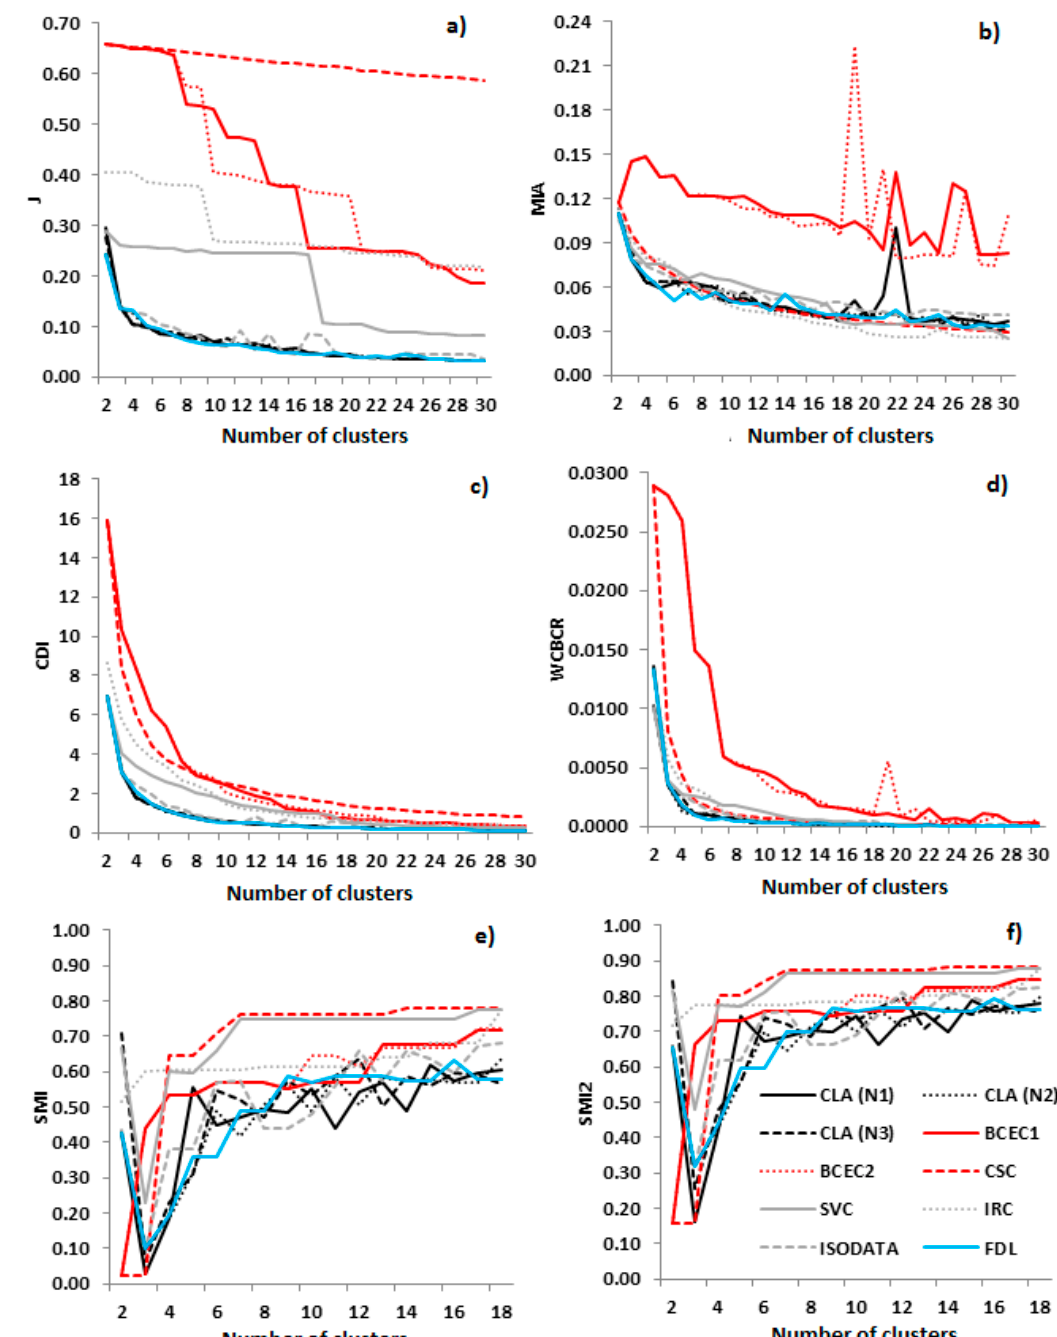
Figure 9. Comparison of the rest algorithms using: ( a ) J, ( b ) MIA, ( c ) CDI, ( d ) WCBCR, ( e ) SMI, ( f ) SMI2. For CLA, 3 different normalization techniques are considered, namely N1, N2 and N3. The N1 performs a random selection of k patterns from the smallest hyper-rectangular that contains all vectors of Y . In the N2, a random selection of k patterns is held. Finally, in N3 the k most dissimilar patterns are selected. After a parametric analysis, the learning rates are set to η = 0.70 and η l = 0.00025 for all validity indicators. The maximum number of iterations is set to 500. The same number is set both for IRC and